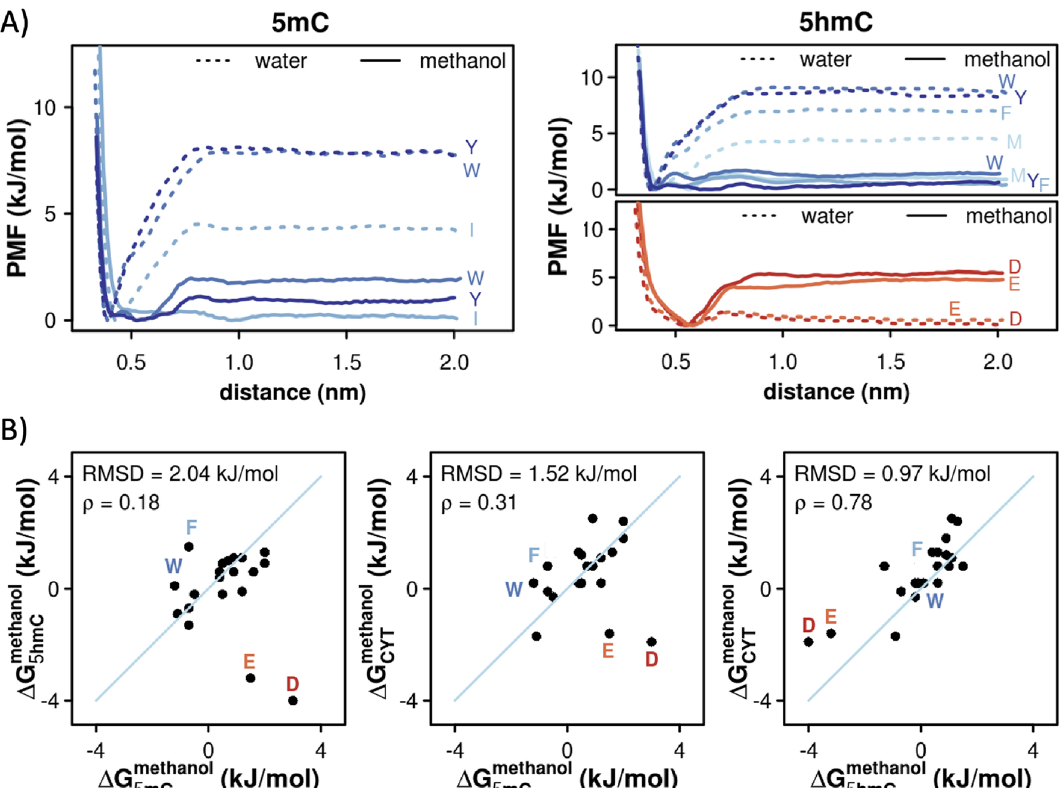
Figure 2. Absolute binding free energies of protein side chains for 5mC and 5hmC. ( a ) PMF curves derived for protein side chains whose affinities for 5mC (left panel) and 5hmC (right panels) change significantly (> 3 kJ/ mol) depending on the surrounding solvent. ( b ) A comparison between sidechain affinity scales in methanol for: 5mC and 5hmC (left panel), 5mC and CYT 12 (middle panel) and 5hmC and CYT (right panel) with the corresponding Spearman correlation coefficients and RMSD values. Side chains that deviate the most in the affinities for the two nucleobases being compared are labeled in color.